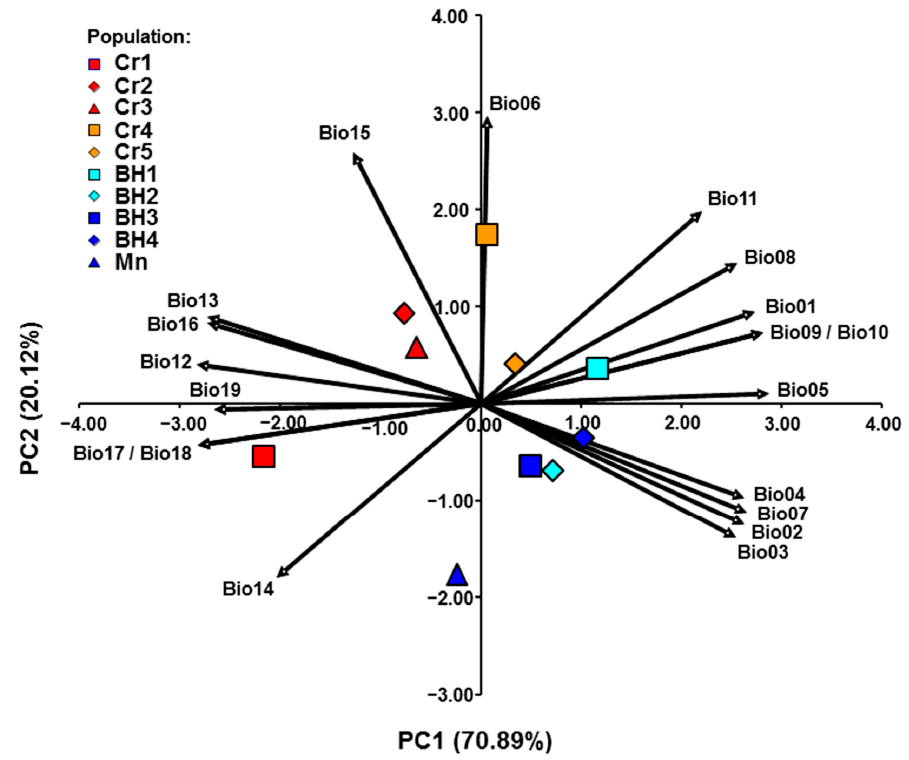
Figure 5. PCA of the investigated Micromeria croatica populations from Croatia (Cr1–Cr5), Bosnia and Herzegovina (BH1–BH4), and Montenegro (Mn) based on 19 bioclimatic variables (Bio1–Bio19). Abbreviations of bioclimatic variables are explained in Table 3.